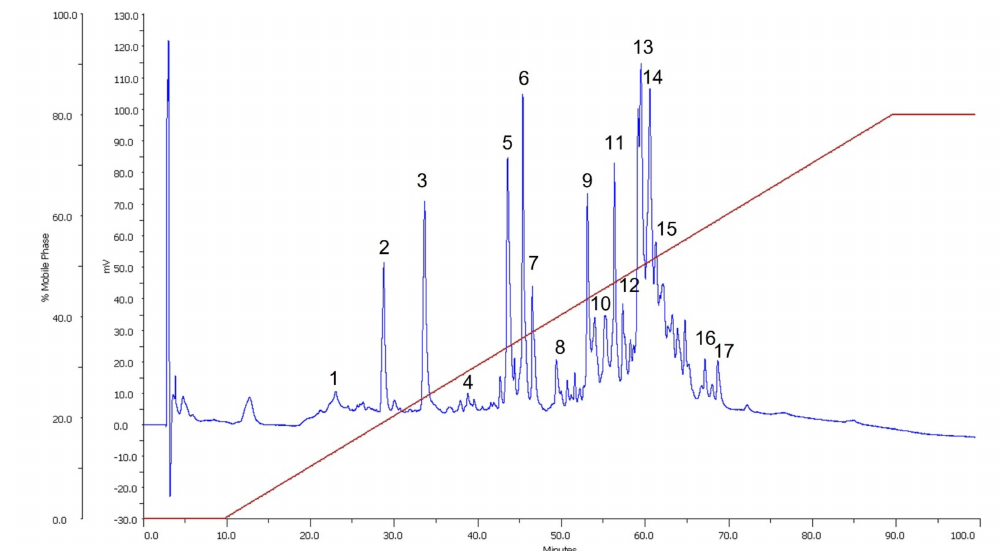
Figure 9. Reverse-phase HPLC separation on Vydac C18 of Latrodectus geometricus venom. The chro- matogram presents the separated fractions from the crude venom separated at a flow rate of 1 mL/min. The red line indicates the gradient of acetonitrile in 0.085% ( v / v ) aqueous trifluoroacetic acid.